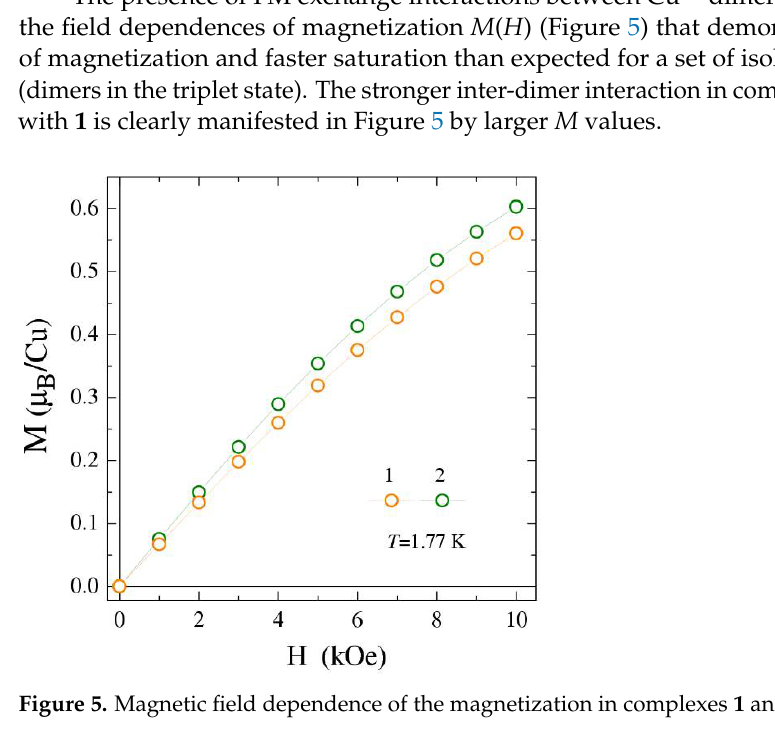
Figure 5. Magnetic field dependence of the magnetization in complexes 1 and 2 at T = 1.77 K.